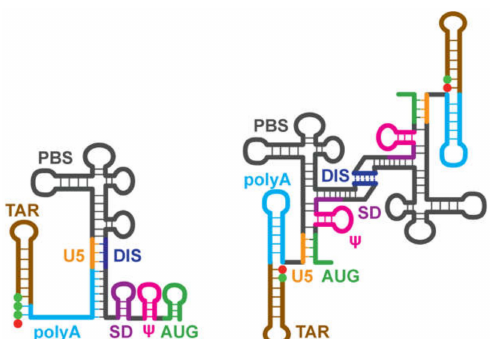
Figure 12. Influence of 5 (cid:48) -guanosine number on RNA structure. Capped RNAs containing two or three 5 (cid:48) -guanosines ( left ) adopt a monomeric structure that exposes the cap and enables RNA processing and metabolism, whereas those with a single capped G ( right ) adopt a cap-sequestered conformation that promotes dimerization and packaging (Cap = red sphere, guanosines = green spheres).